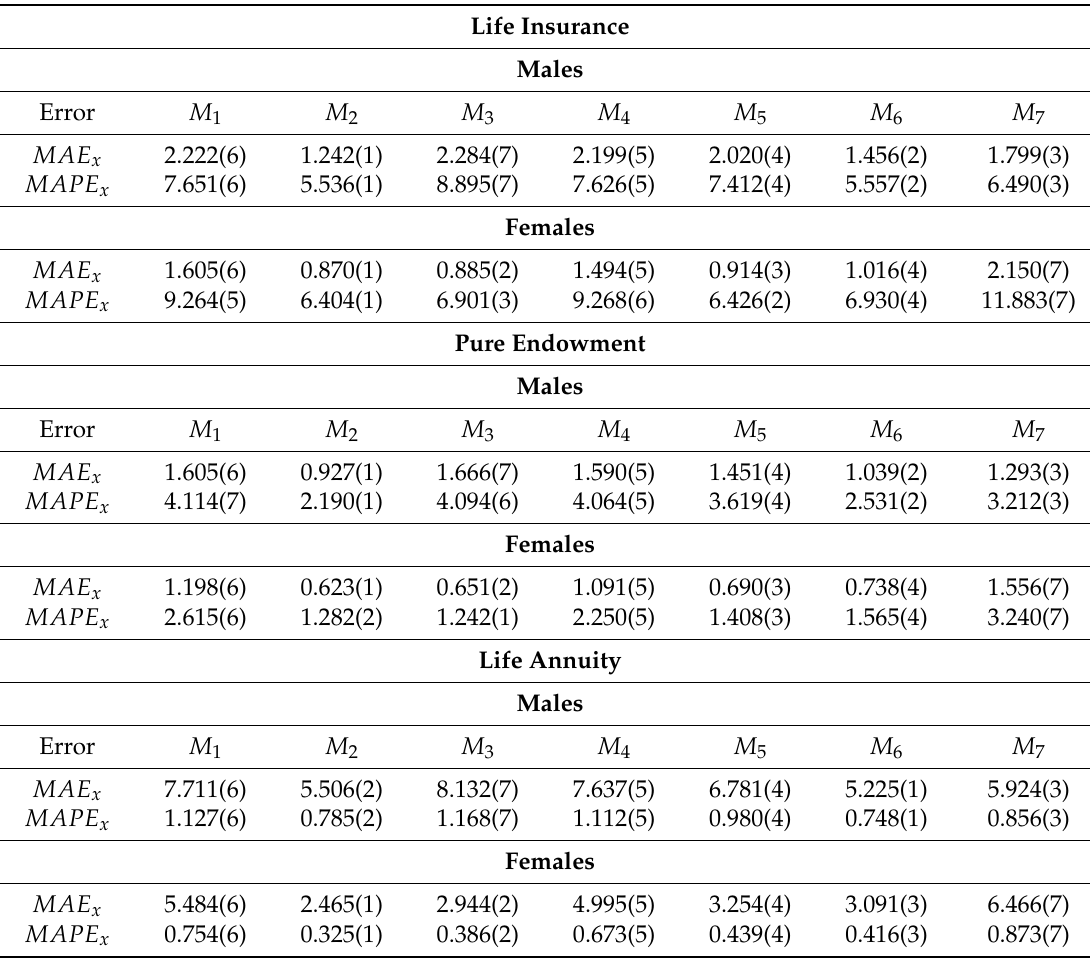
Table 7. Averaged values (ranking order in brackets) of MAE and MAPE measures for 10 year forecasted life insurance, pure endowment and life annuity values using actual jump-off rates for males and females, aged 60–79 in